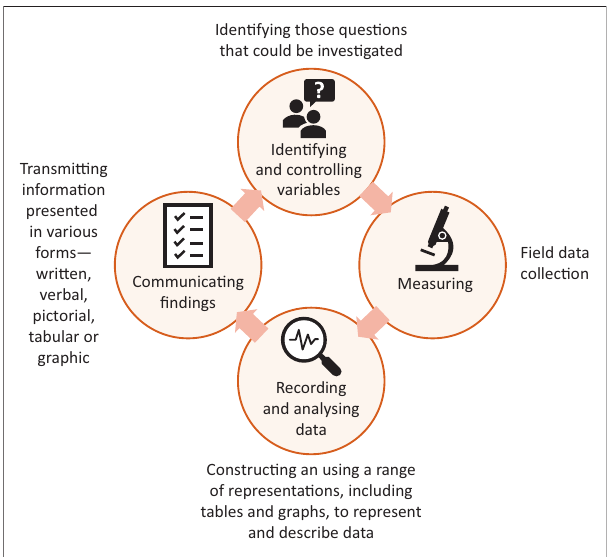
FIGURE 1: Inquiry-based